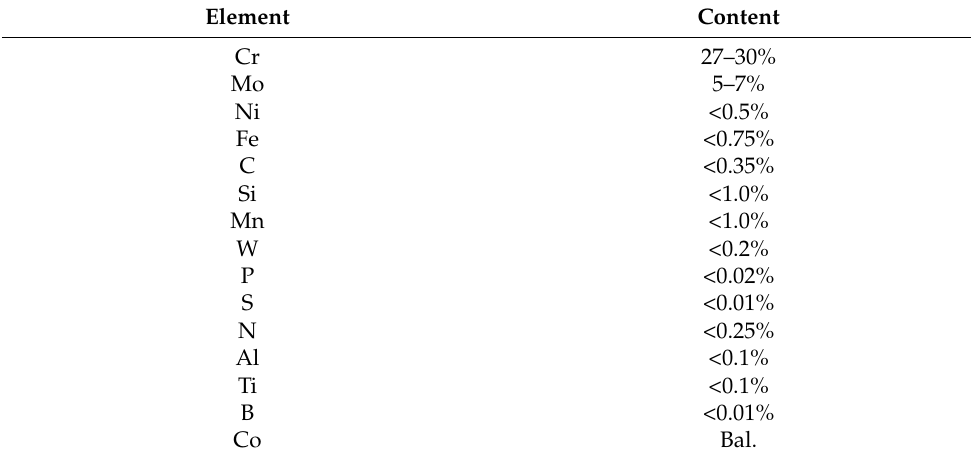
Table 1. Chemical composition (wt%) of the studied Co-Cr-Mo alloy.